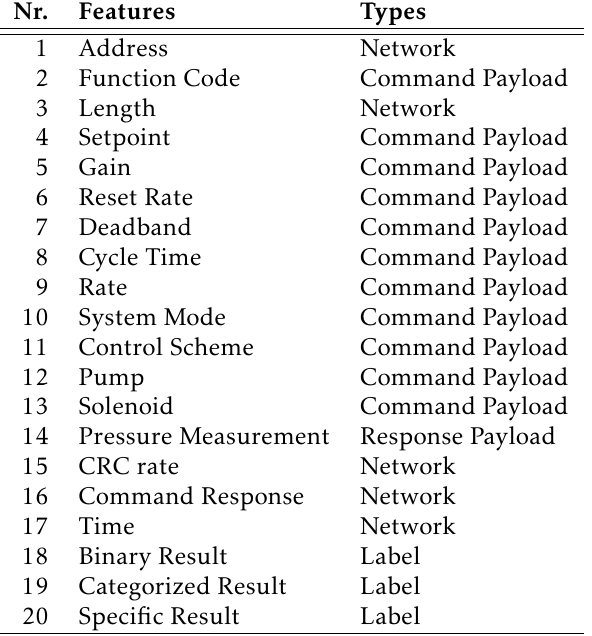
Table 1. List of features from the gas pipeline data set. Nr.